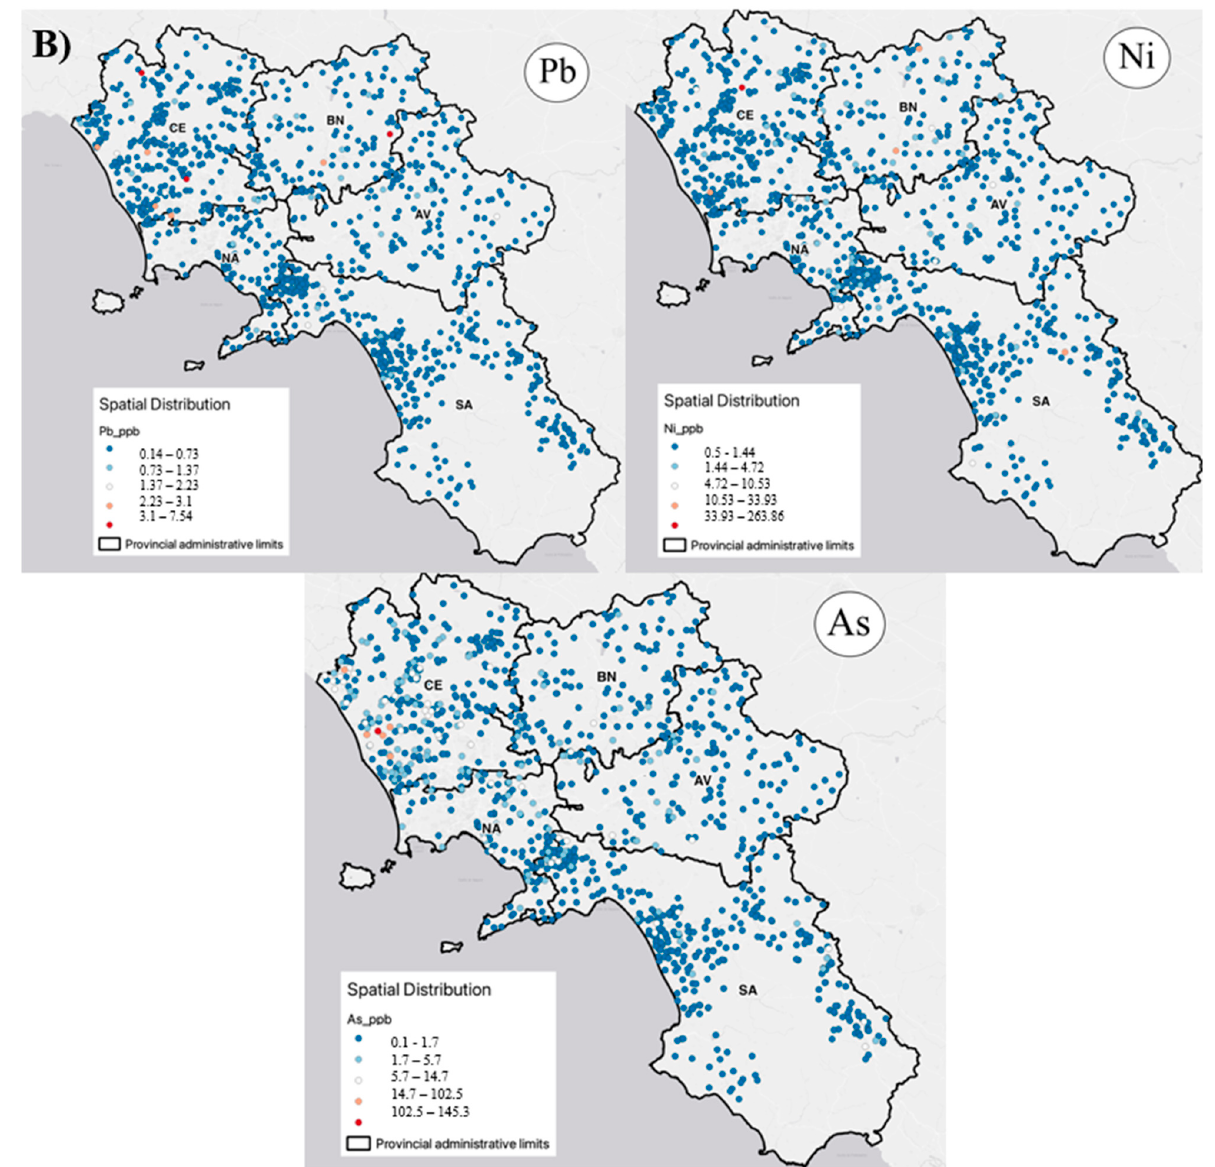
Figure 2. Spatial distribution of heavy metals in groundwater of Campania Plain. In ( A ) heavy metals B, Al, Fe and Mn are represented, while in ( B ) heavy metals Pb, Ni and As are represented.